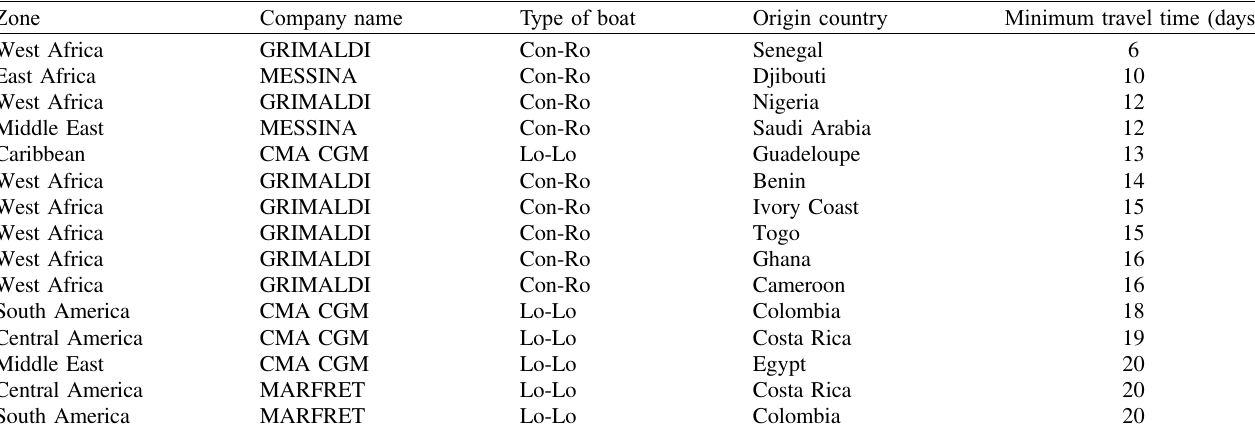
Table 3. Twenty riskiest shipping lines in connection with the port of Marseille. Con-Ro and Lo-Lo are de fi ned in the materials and